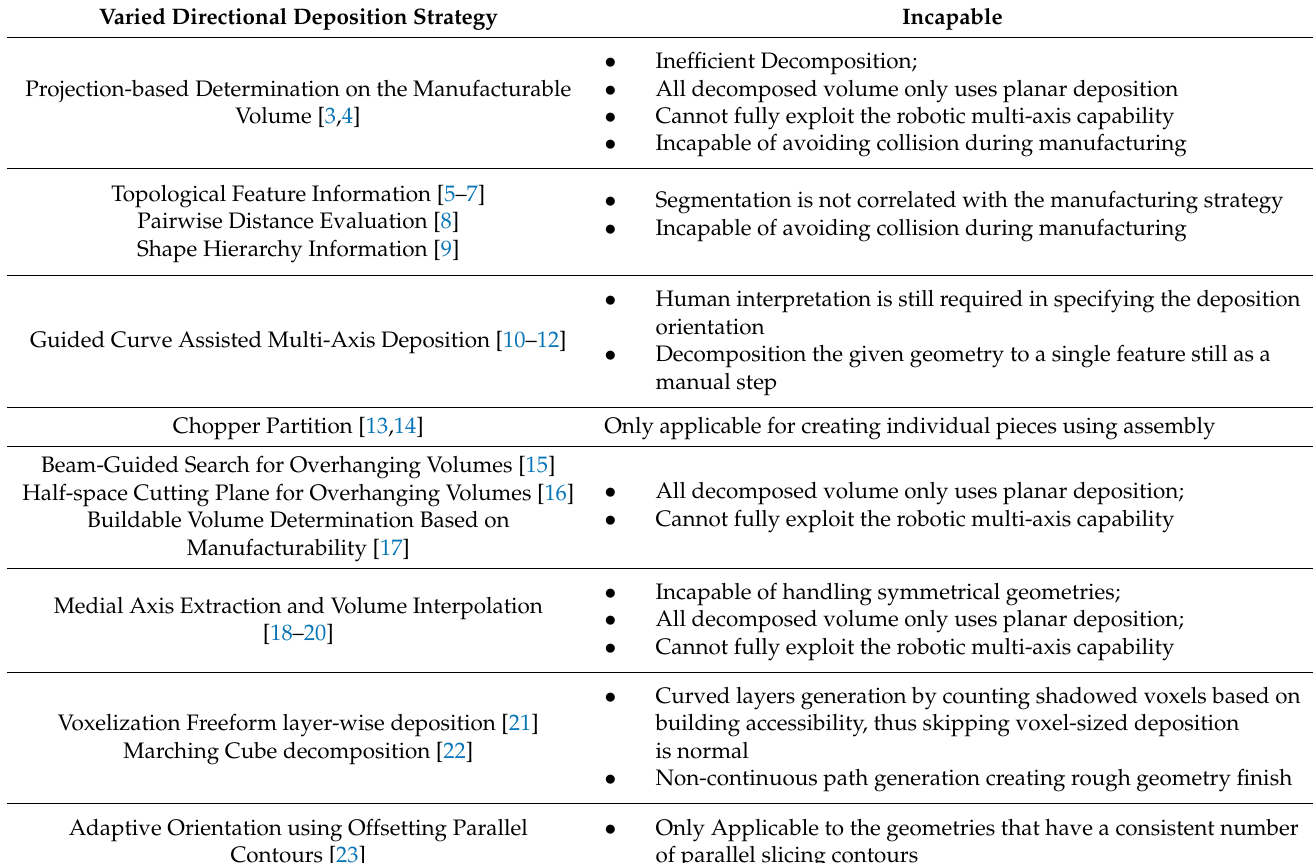
Table 1. Capability of existing decomposition methodology and corresponding